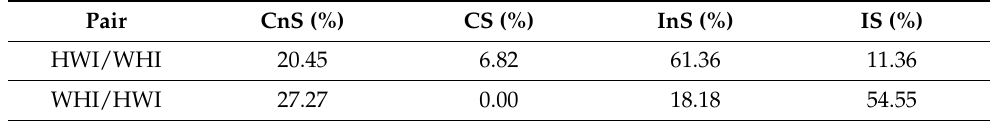
Table 3. Percentage values from counts of LCLQ results classes for WHI and HWI pairs. The abbre- viations have the following meanings: CnS = collocated not significant; CS = collocated significant; InS = isolated not significant; IS = isolated